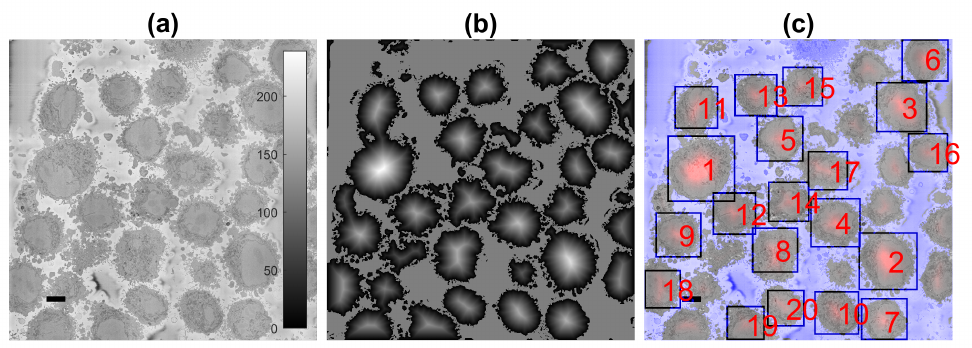
Figure 2. Automatic identification of cells from 8192 × 8192 images. ( a ) One representative slice with many HeLa cells. The scale bar corresponds to 5 µ m. ( b ) Illustration of the detected background (grey constant shade) and distance transform (grey to white) that corresponds to the cells; the larger the cell is, the brighter the intensity of the transform. ( c ) Composite image of the slice as in ( a ), background as a purple shade and 20 detected cells, ranked in order of size. It should be noted that smaller cells were not selected as there was a limit of 20 in the present example.